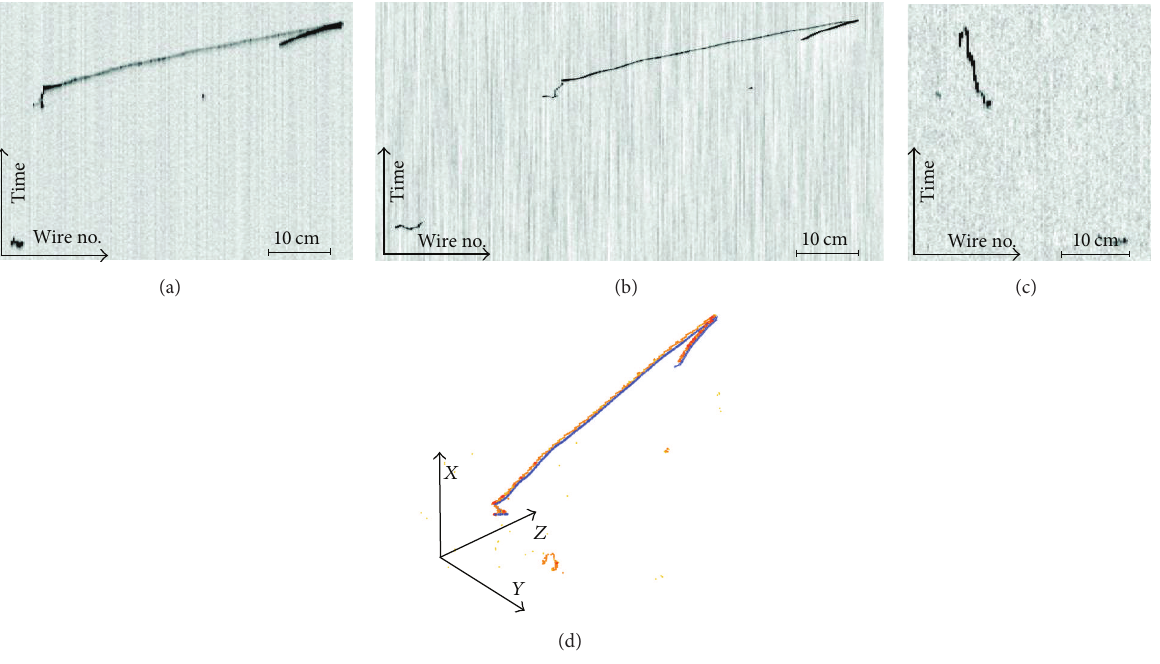
Figure 9: Simulated decay chain of 𝐾 + → 𝜇 + ] 𝜇 → 𝑒 + ] 𝑒 ] 𝜇 : (a) Collection view; (b) Induction2 view; (c) Induction1 view; (d) 3D reconstruction; MC cells are marked with orange dots, and reconstructed track is marked with blue curve. The tracks of all three particles were reconstructed together to show the capability of reconstructing narrow angles between